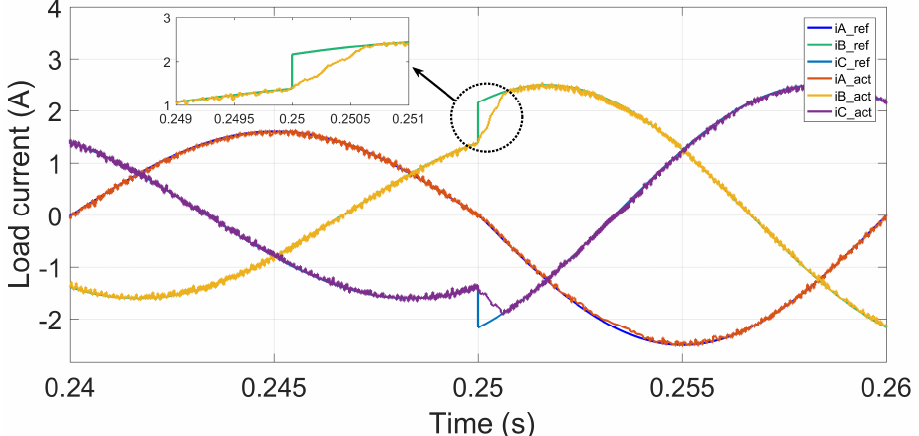
Figure 12. The waveform showing the actual load current i A (i A_act ) tracking the reference current (i A_ref ) for T s = 20 μs.